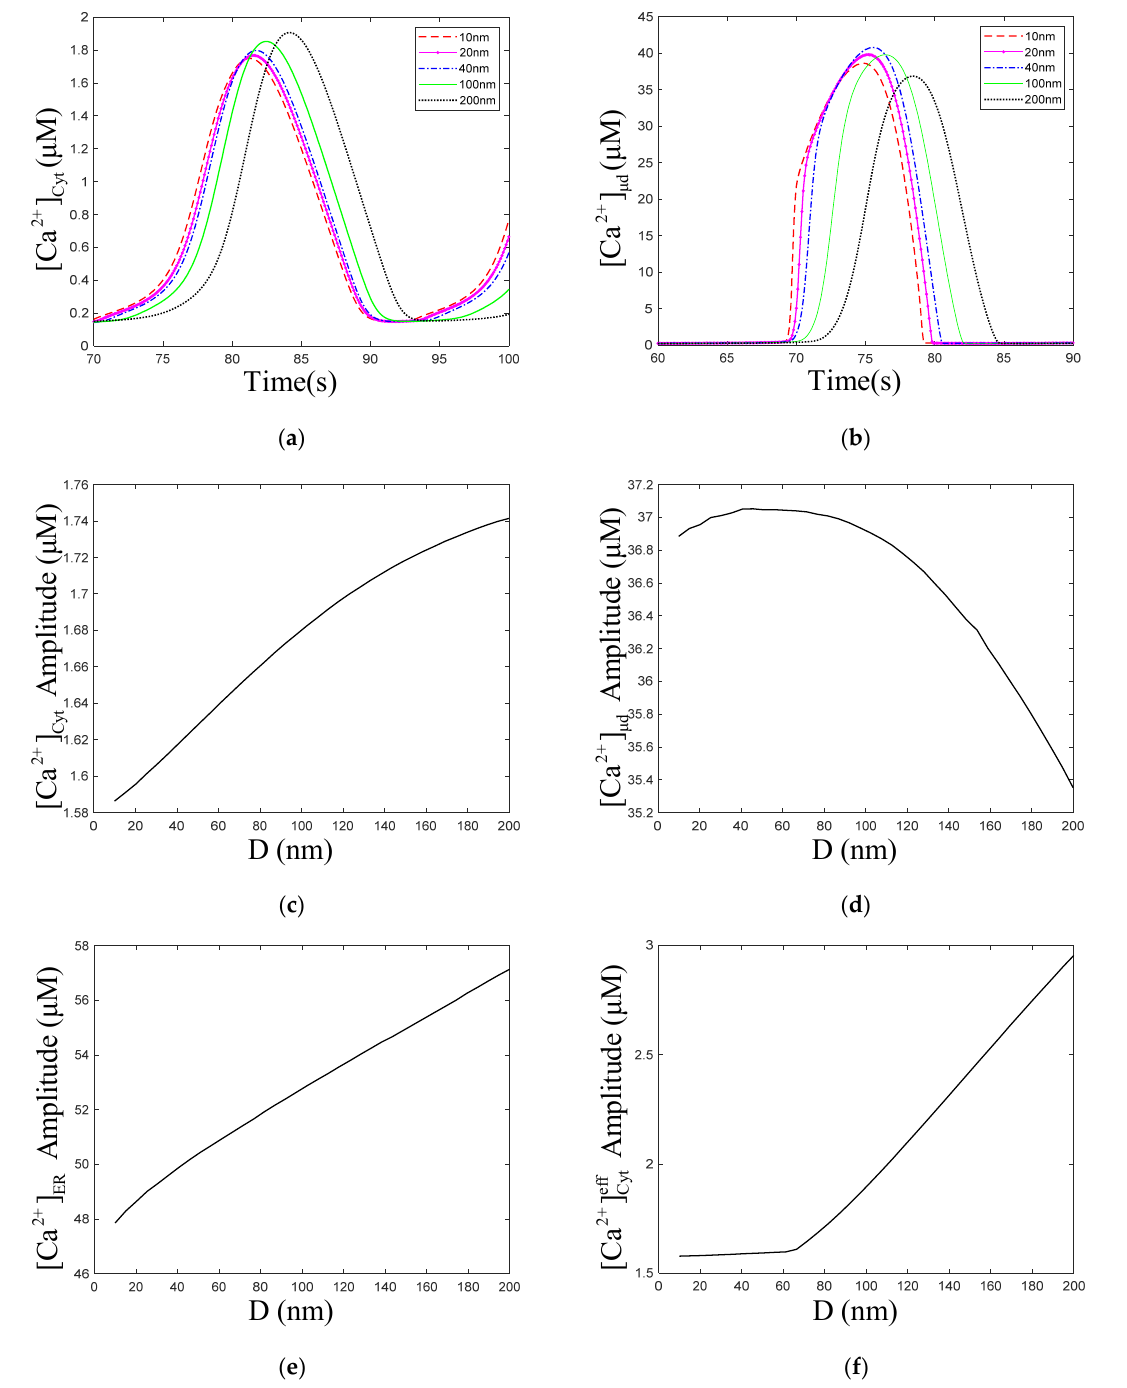
Figure 6. Dynamics modulated by the ER–Mt distance ( D ). V PLC = 1 µ M s − 1 , k deg = 1.5 s − 1 , K PLC = 0.12 µ M, K deg = 0.1 µ M. Stimulation applied at 50 s. The other parameters and constants are taken from Table 1. ( a ) Ca 2 + concentration of Cyt ( [ Ca 2 + ] ) oscillations as a function of time at the following different D s: D = 10, 20, 40, 100 and 200 nm. ( b ) Ca 2 + concentration of µ d ( [ Ca 2 + ] µ ) oscillations as a function of time at the following different D s: D = 10, 20, 40, 100 and 200 nm. ( c ) The amplitudes of Ca 2 + concentration of Cyt ( [ Ca 2 + ] ) oscillations as a function of D . ( d ) The amplitudes of Ca 2 + concentration of µ d ( [ Ca 2 + ] µ ) as a function of D . ( e ) The amplitudes of Ca 2 + concentration of ER [ Ca 2 + ] as a function of D . ( f ) The amplitudes of Ca 2 + concentration of effective cytosolic compartment ( [ Ca 2 + ] ) as a function of D . With the increase in the ER–Mt distance, ( a ) the amplitude of [ Ca 2 + ] oscillations increases, ( b ) the amplitude of [ Ca 2 + ] µ oscillations decreases. ( d , f ) show that the effect of D in calcium oscillations is weak when D is great than 65